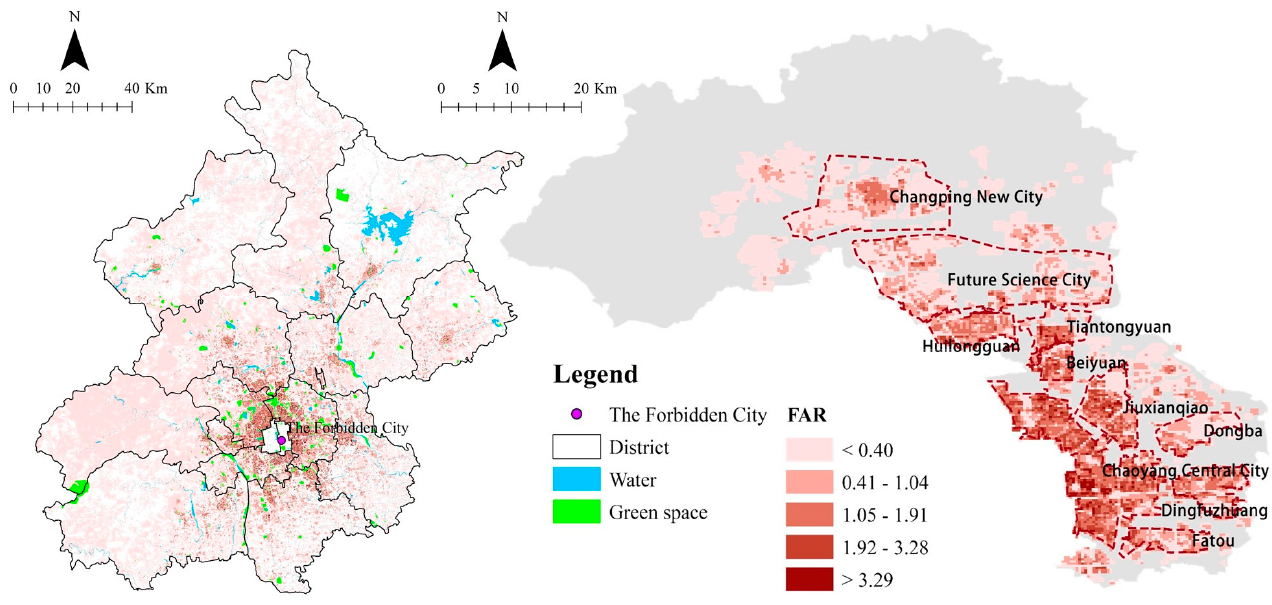
Figure 1. Study area.